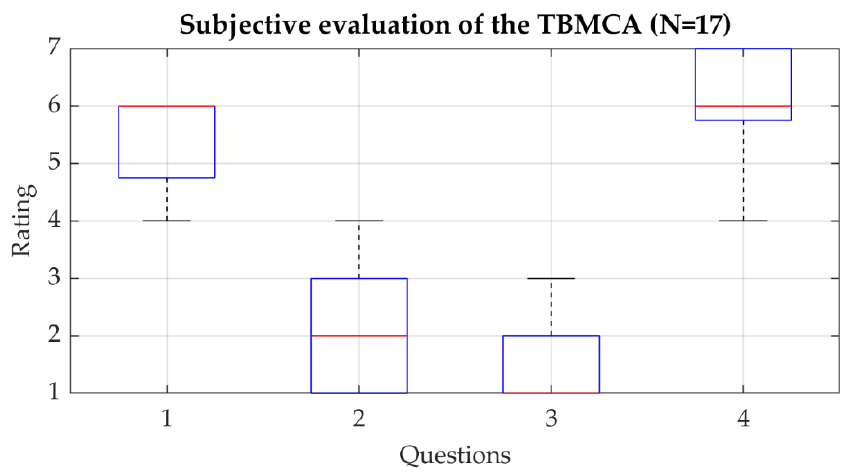
Figure 7. Results of the subjective evaluation of the TBMCA. For all four questions, Wilcoxon signed-rank tests were applied. The test statistics indicate that the median values (6, 2, 1, 6) deviate significantly from the scale median value of 4 at the 0.1% significance level ( p <